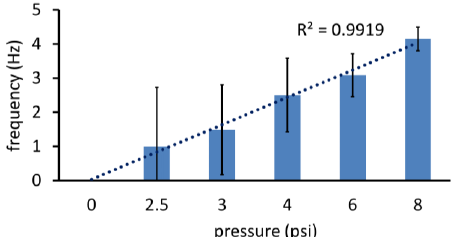
Figure 3. Oscillator performance with different magnitudes of constant vacuum supply. Error bars denote SD across three devices. The linear trend correlates closely with the frequency–vacuum relationship.